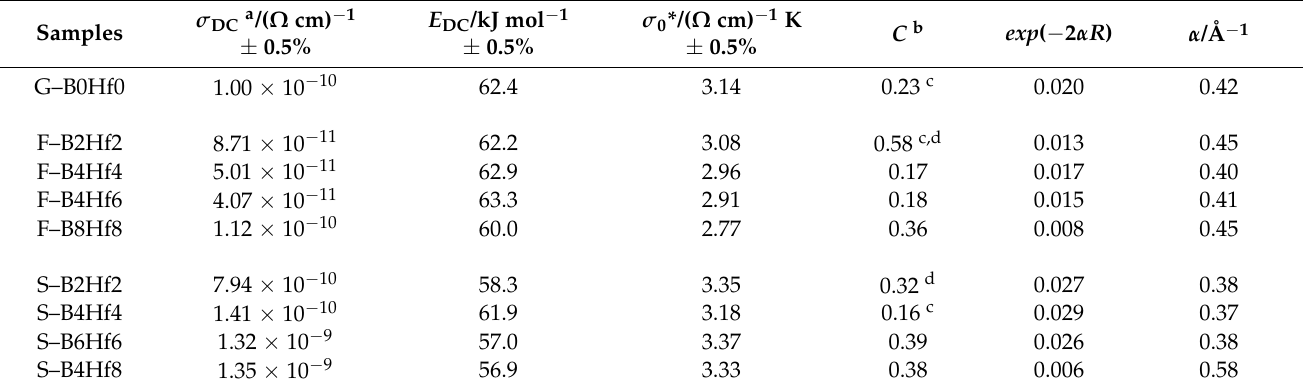
Table 2. Batch compositions and selected properties of studied iron phosphate-based glasses contain- ing B 2 O 3 and HfO 2